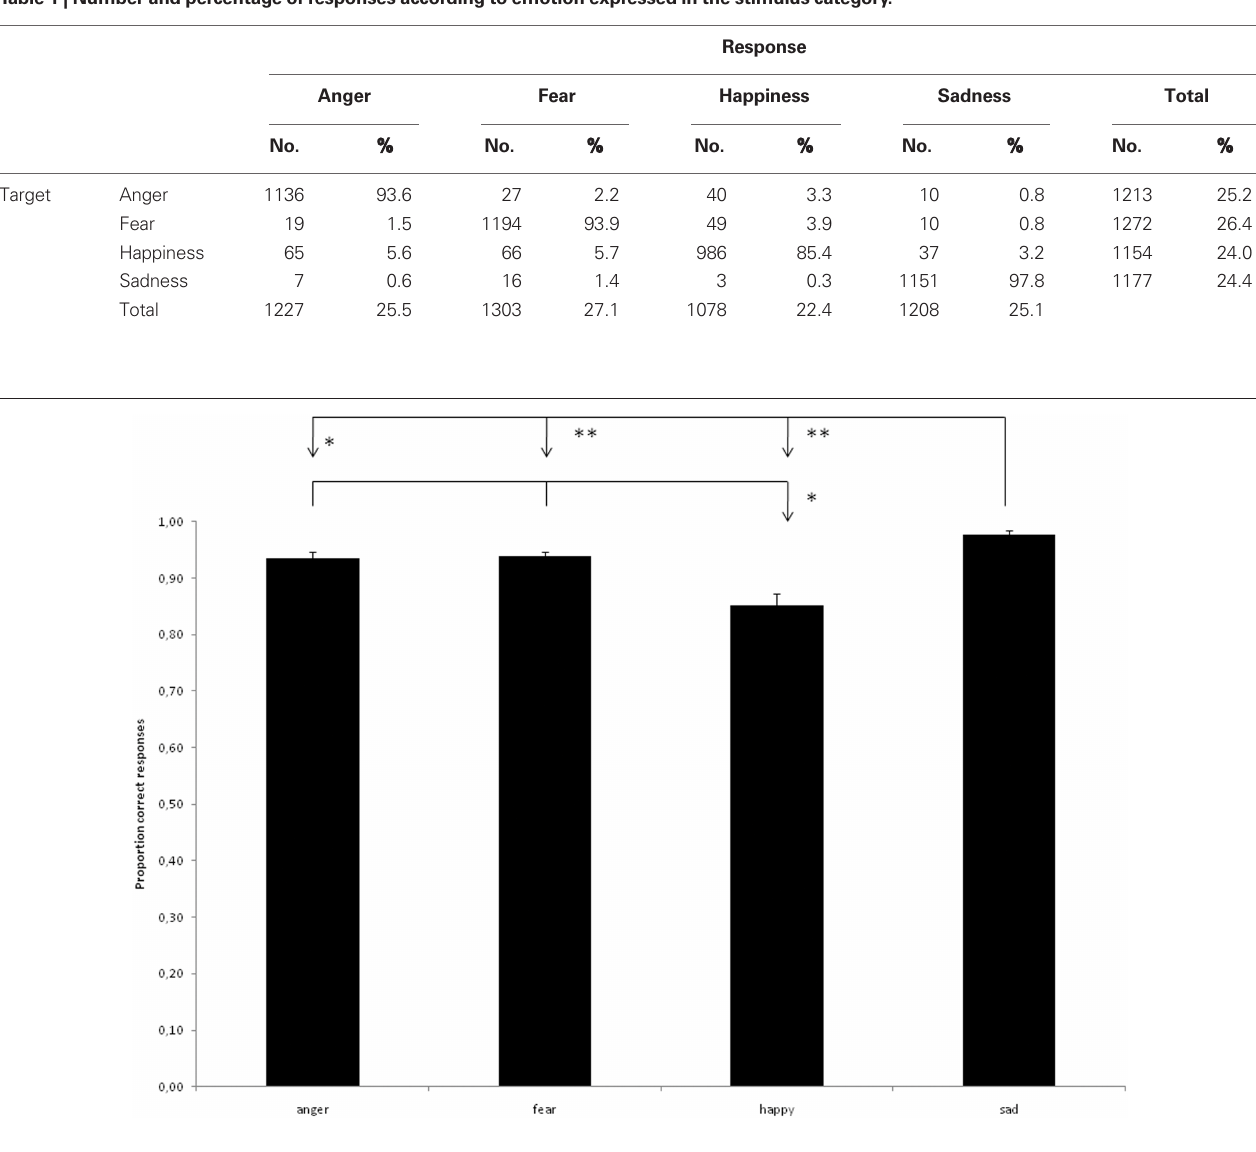
Figure 2 | Proportion correct categorizations according to bodily expression. * p < 0.01, ** p <